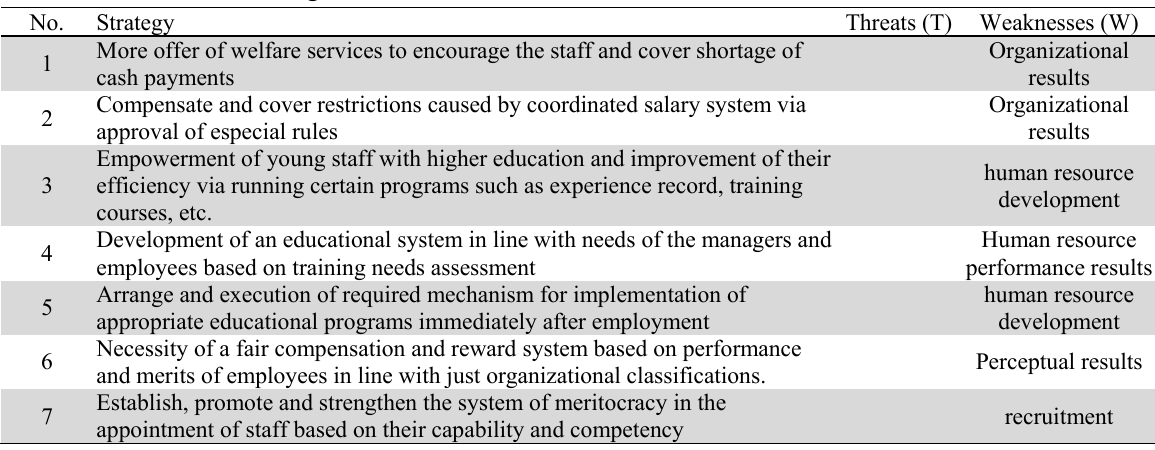
Human resource WT strategies